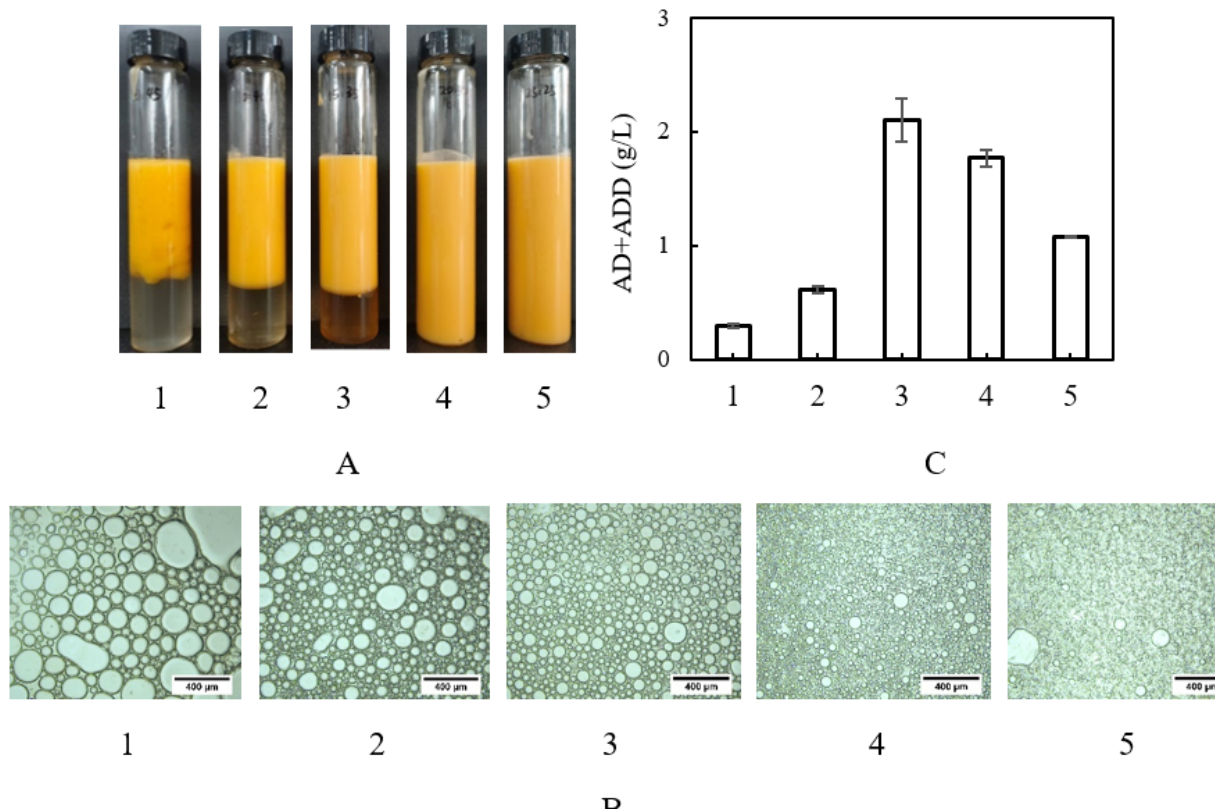
Figure 2. Effects of the volume ratio of soybean oil to water: ( A ) Emulsion fraction. ( B ) Microscopic emulsions (bar = 400 μ m). ( C ) AD and ADD concentrations. In the basic experimental condition, the total volume of the soybean oil and the aqueous culture medium was 50 mL. There was no glucose in the aqueous culture medium. The concentration of phytosterols in the soybean oil was 25 g/L. The microbial transformation time was 7 days. No. 1, 2, 3, 4, and 5 corresponded to volume ratios of soybean oil to the aqueous culture medium of 5:45, 10:40, 15:35, 20:30, and 25:25 mL, respectively.